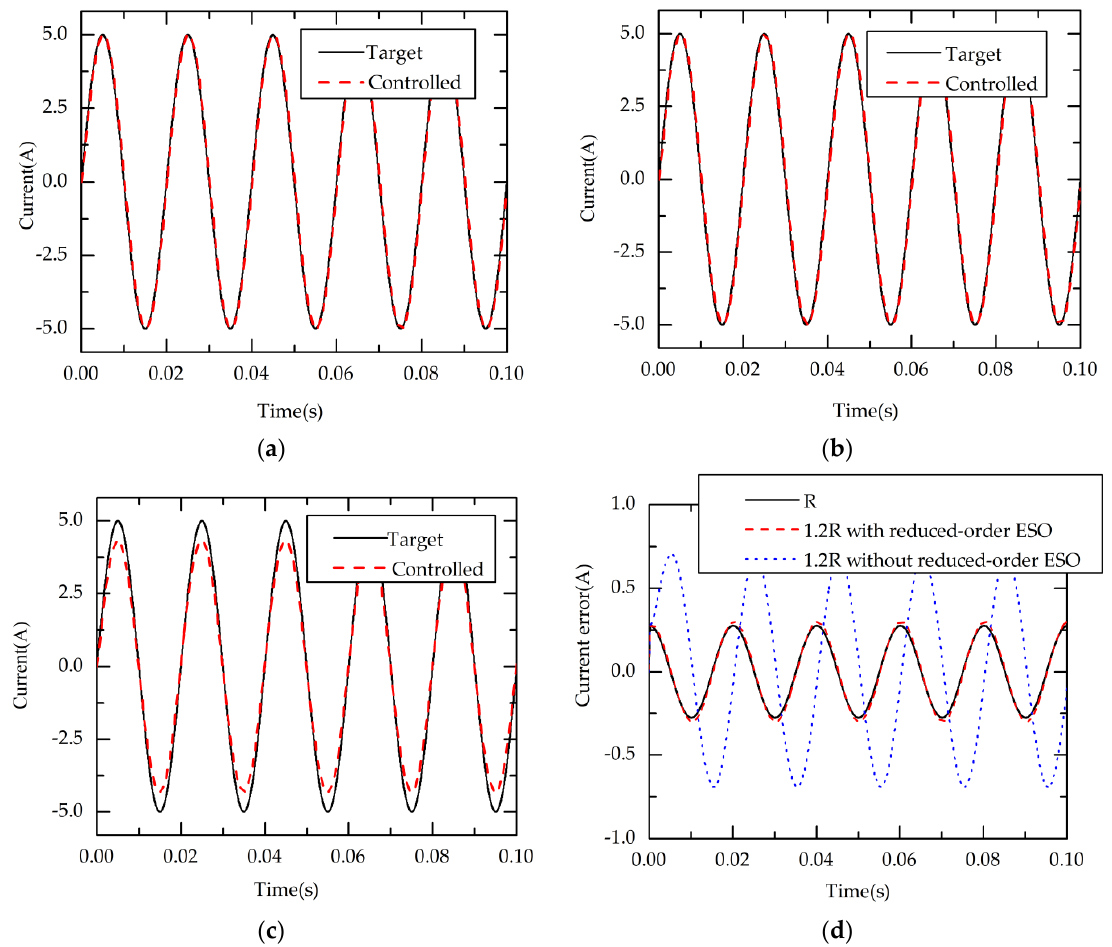
Figure 6. Simulation results of the current loop: ( a ) R equals the nominal value, controller with reduced-order extended state observer (ESO); ( b ) R is 20% higher than the nominal value, controller with reduced-order ESO; ( c ) R is 20% higher than the nominal value, controller without reduced-order ESO; and ( d ) Current tracking error. Table 1. Main parameters of the linear electromagnetic actuators (LEMA).